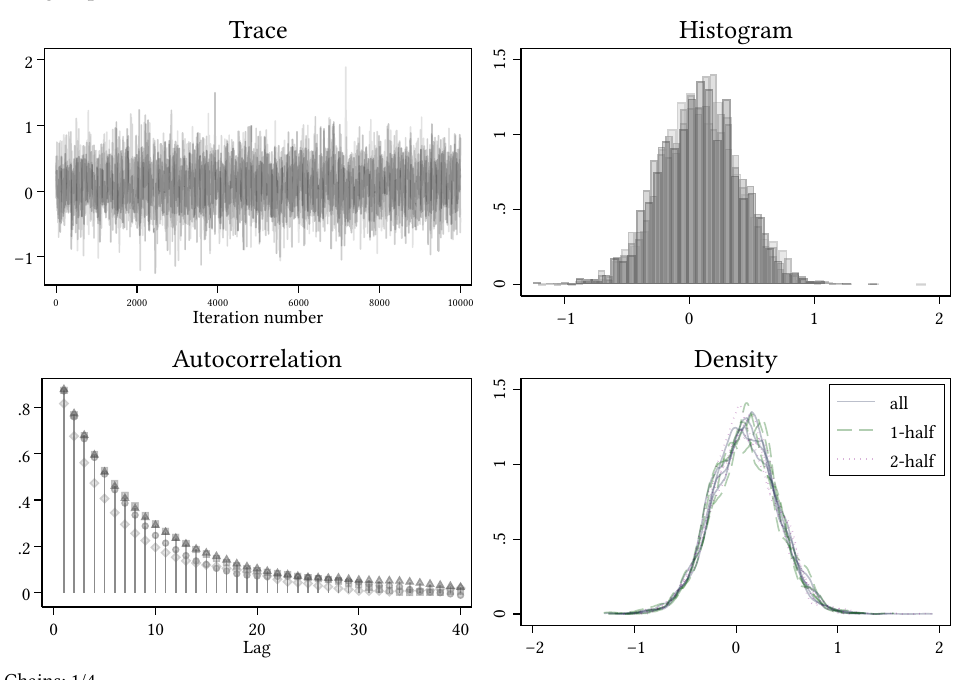
Figure A8. How awareness of the lowest asks influences the response to the market price. The Low Info